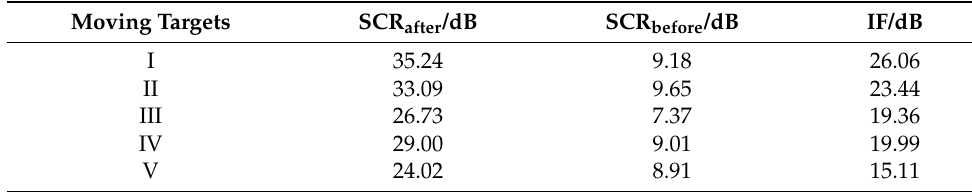
Figure 11. Processing result of the simulated moving targets in stationary scene in a 4-channel HRWS SAR system, ( a ) the deramp processing for a set of subsampled data, ( b ) the first layer of the channel cancellation, ( c ) the second layer (the last layer) of channel cancellation, ( d ) estimated results of the radial velocities of the five simulated moving targets. Table 5. SCR and IF of the simulated moving